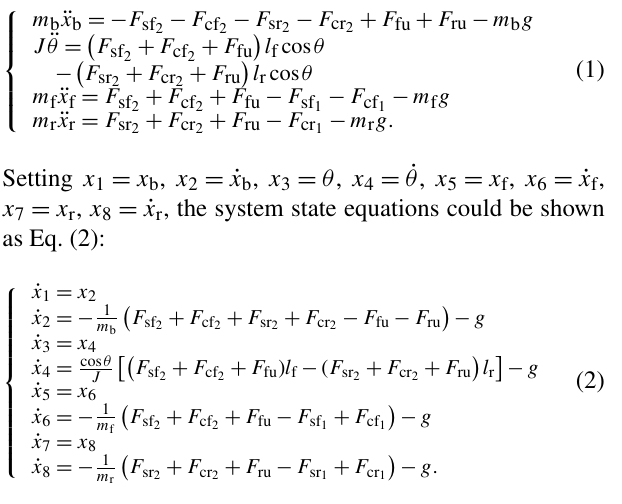
2 Simulation model